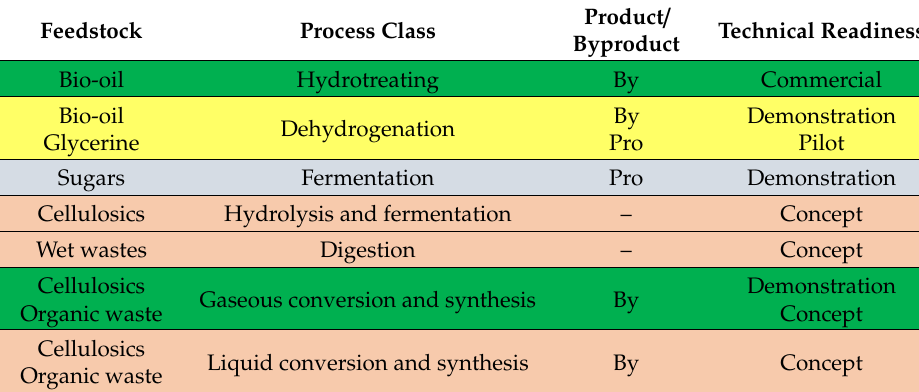
Table 1. Feedstock-process summary for